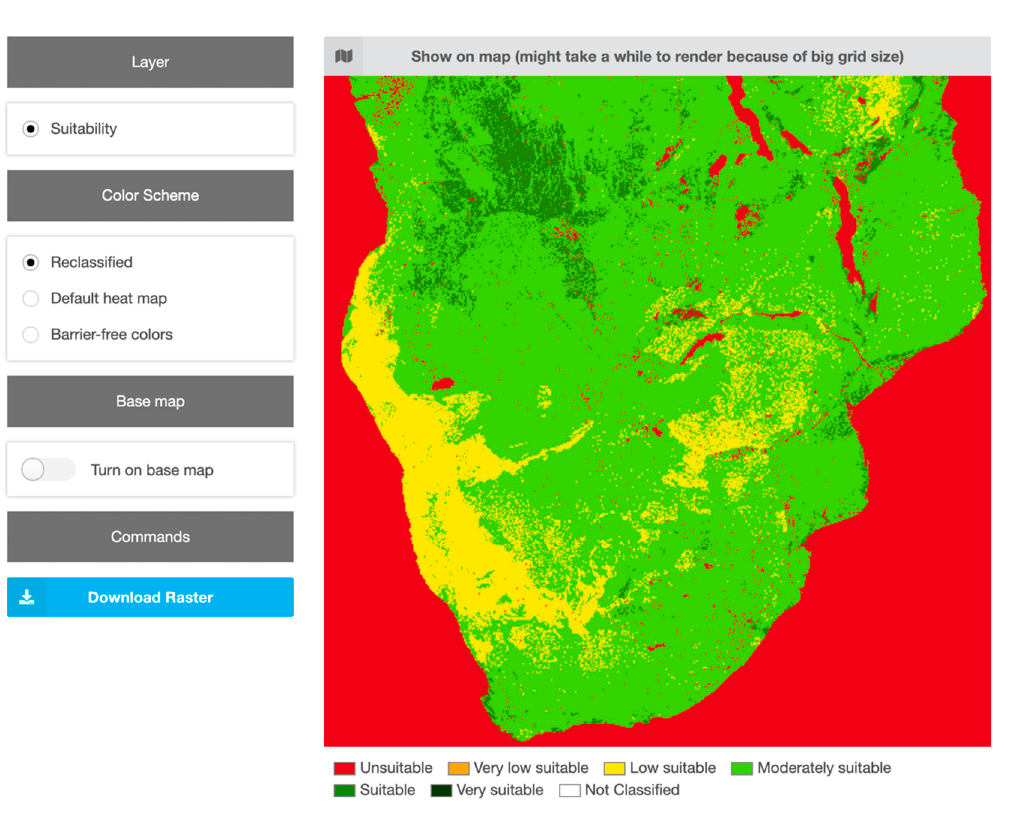
Figure 4. Interface of web-GIS tool, showing the final suitability map with redefined suitability classes.